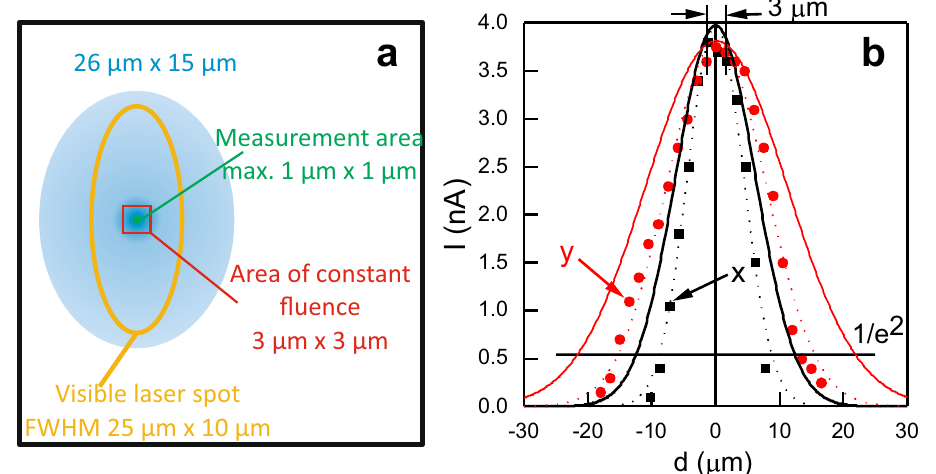
Figure 2. Adjustment of laser spot into tunneling gap: ( a ) Schematics ( b ) Dependence of photo-electron current I on lateral position d on the sample within the laser spot for an absorbed SPP fluence of 297 µ J/cm 2 ; incoming SPP fluence: 5.32 mJ/cm 2 , 10 7 pulses; 72 fs; thin dotted lines are Gaussian fits to the data and thick lines the square root of these